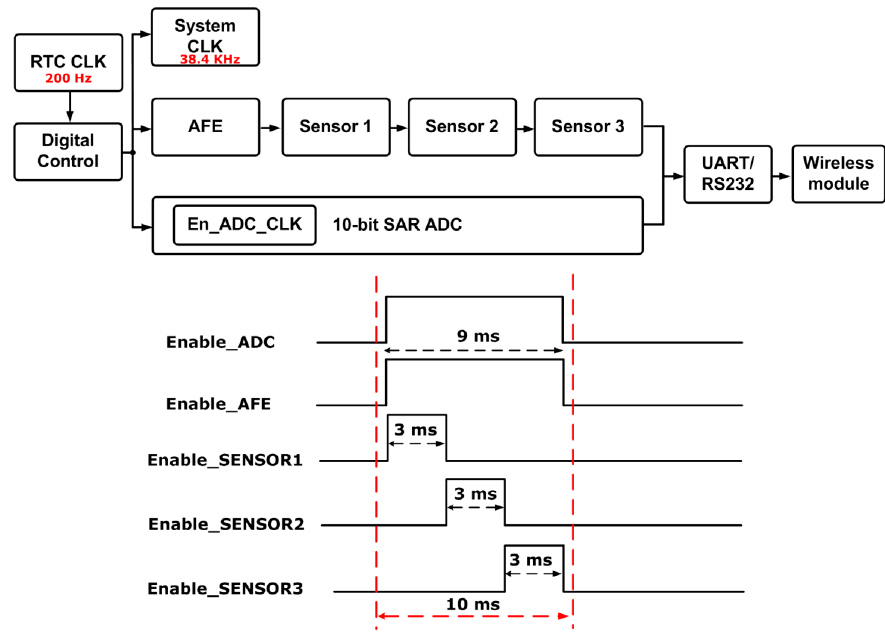
Figure 3. The control flow chart and the timing diagram.